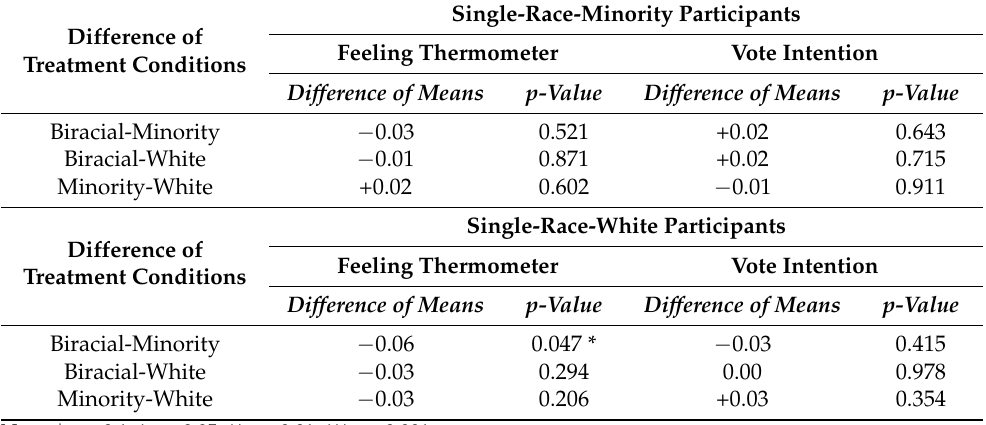
Figure 4. Mean feeling thermometer and vote intention ratings of hypothetical candidates. All six treatments are represented here and grouped by each identity cue (e.g., “White” denotes candidates from both the Asian and White heritage and the Black and White heritage treatment conditions who identified as “European American”. Sample includes only single-race participants who indicated having two parents who share the same race (i.e., either two White parents or two single-race- identified minority parents). X -axis denotes different treatment groups based on the identity cued by our hypothetical candidates. Note: error bars denote 95% confidence intervals. Table 4. Results from difference-of-means t -tests for all possible treatment group comparisons in Figure 4.